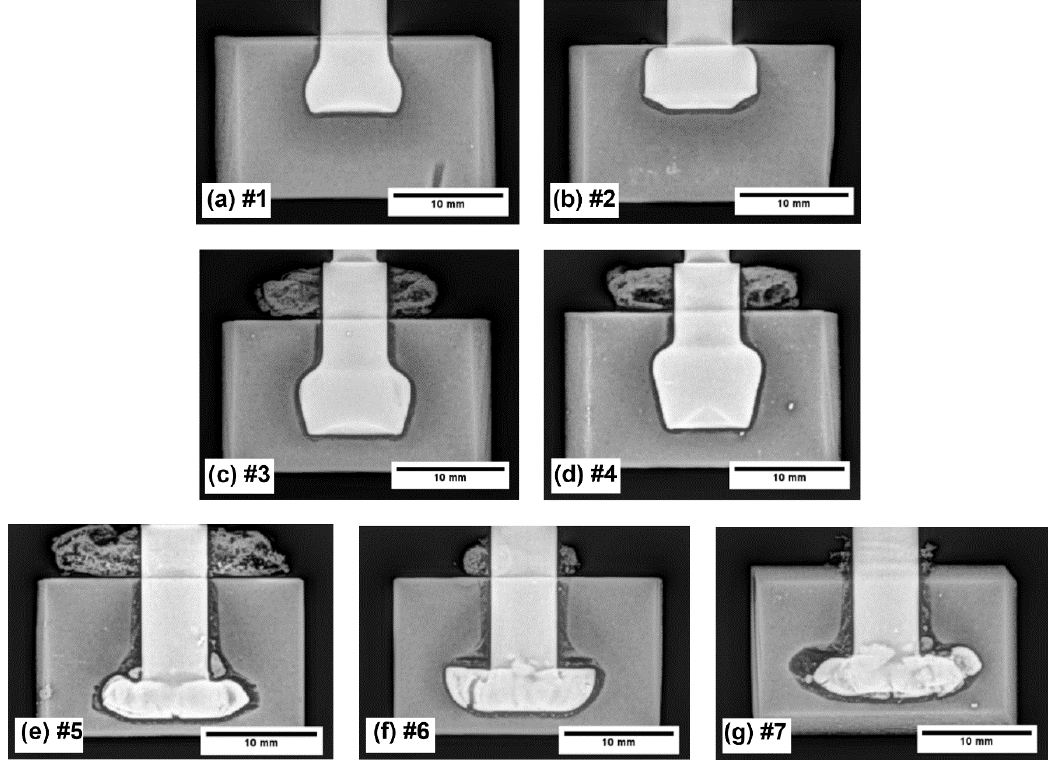
Figure 2. X-ray images of rivet shape and its position inside the base PEI material block (* Note : numbers (#1–#7) by the image captions ( a – g ) represent the sample designation using different manufacturing parameters—see Table